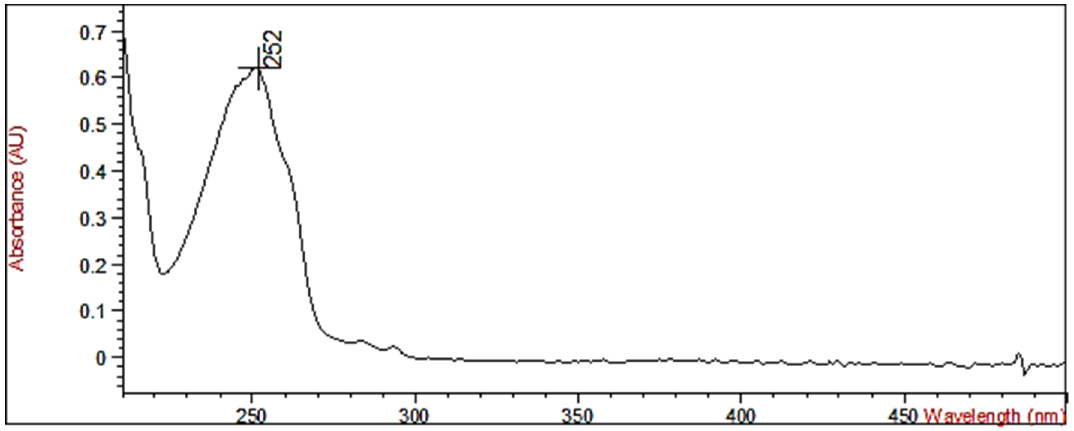
Figure 2. UV-Vis spectrum of